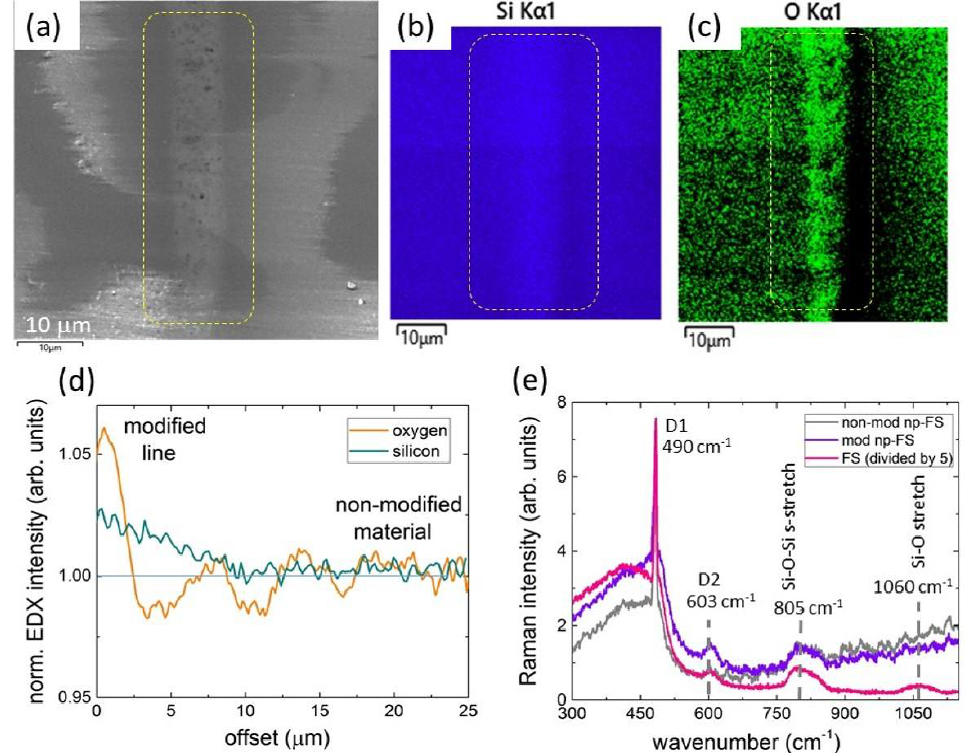
Figure 5. ( a ) Cross-sectional top-view SEM image of three-line segment in np-FS (1030 nm, 0.3 ps. 0.03 μ J). ( b , c ) EDX maps of oxygen and silicon, indicating compaction in the segment. ( d , e ) Raman spectra of the segment and background in np-FS in comparison to reference spectrum of bulk FS (spectral assignment after [27]).